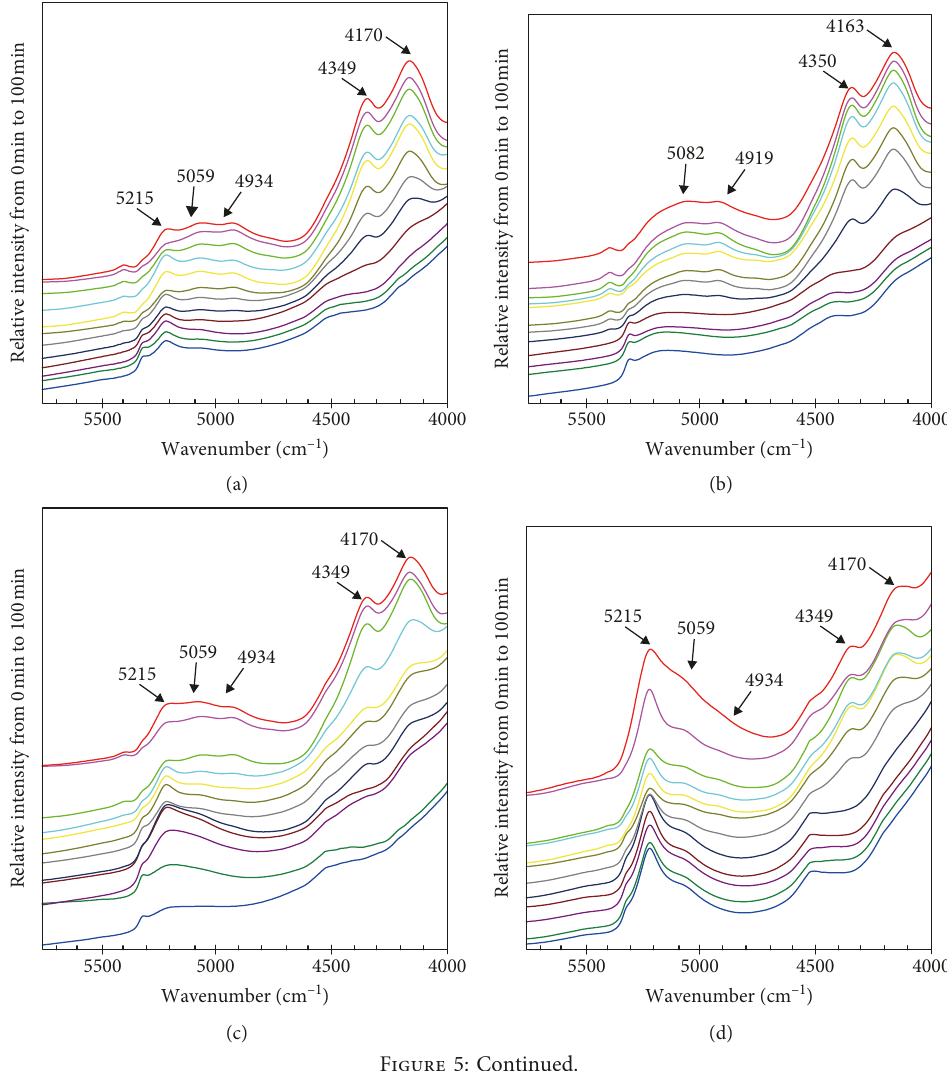
Figure 4: NIR spectra of 8 batches of calamine samples during calcination in the 7500–5750cm hemimorphite). (b) S2 (hydrozincite). (c) S3 (hydrozincite, hemimorphite, and dolomite). (d) S4 (hydrozincite, hemimorphite, and dolomite). (e) S5 (hydrozincite, hemimorphite, dolomite, and calcite). (f) S6 (hydrozincite). (g) S7 (hydrozincite, hemimorphite, dolomite, and calcite). (h) S8 (hydrozincite and